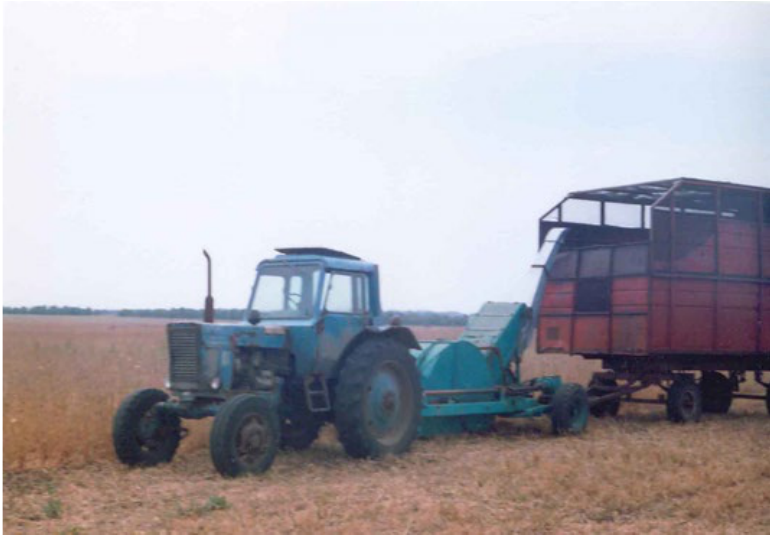
Figure 7. General view of the harvesting unit.